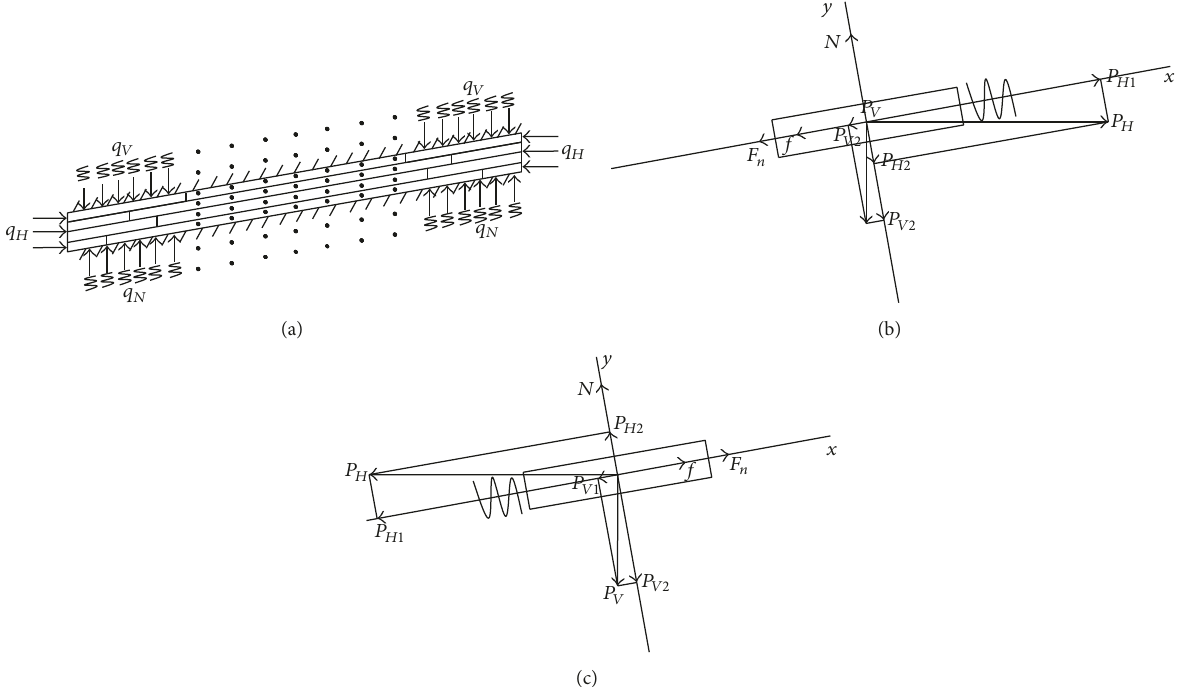
Figure 5: Diagrams of rock structural mechanics models; (a) diagram of rock structural mechanics model for the physical model; (b) diagram of rock structural mechanics model for stratum in the left of physical model; and (c) diagram of rock structural mechanics model for stratum in the right of physical